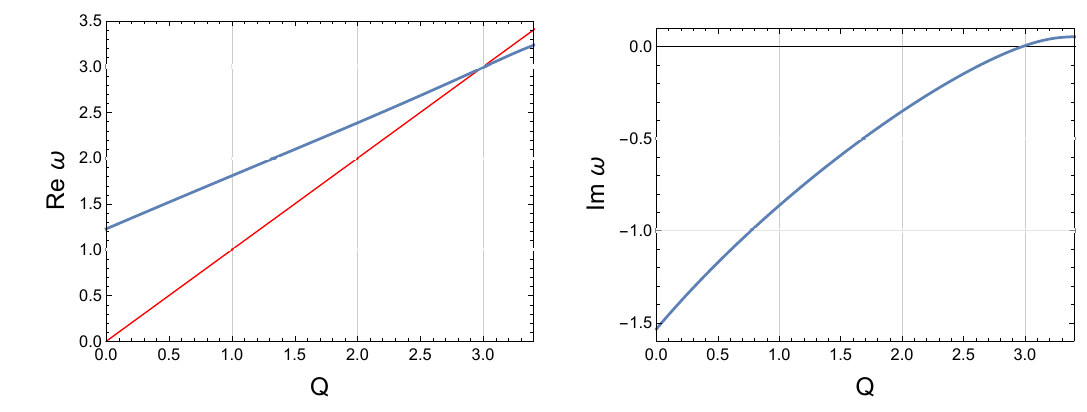
Figure 6 . Location of the quasinormal mode frequencies for Q = 0 (left) and Q = 2 . 5 (right) when e = 1 . The red vertical lines in the right panel show the boundaries of the superradiant condition 0 < ω < e Φ H .